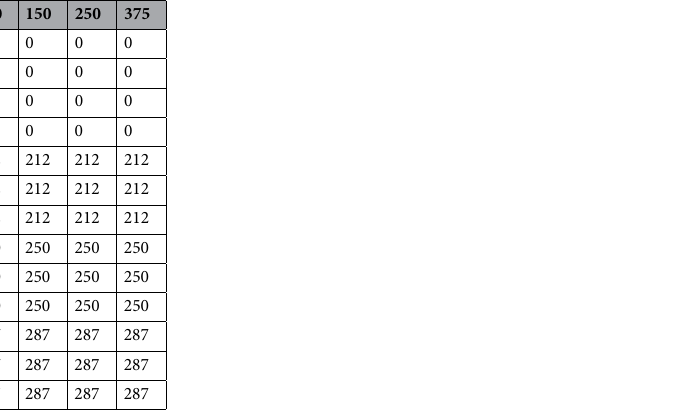
Table 6. Cutting forces F c for diverse variants of feed F f and trust F p forces used for the numerical analysis of saw blades.